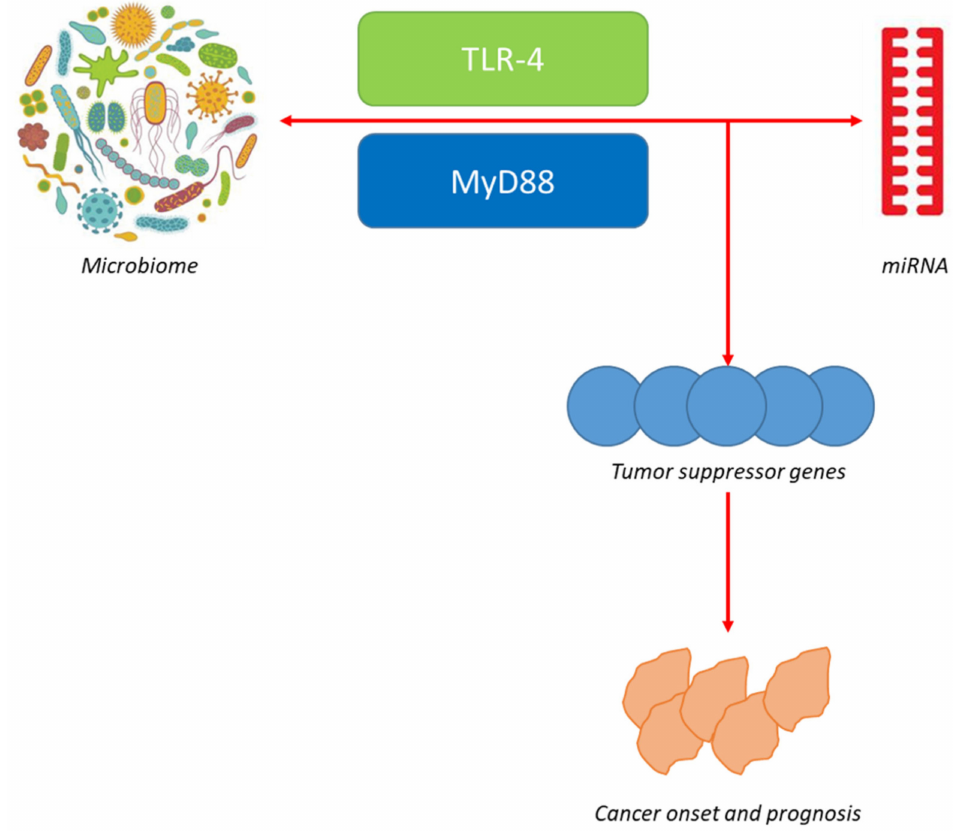
Figure 1. Interaction between microbiome and microRNA. An alteration of microbiome is thought to a ff ect the regulation of various miRNAs through the MyD88-dependent pathway. miRNA alteration is, in turn, associated with gut dysbiosis; however, its re-balance would re-establish gut microbiome. The alteration of microbiome and miRNAs brings to an altered production of oncogenes and / or tumour suppressor genes, in turn a ff ecting cancer onset and